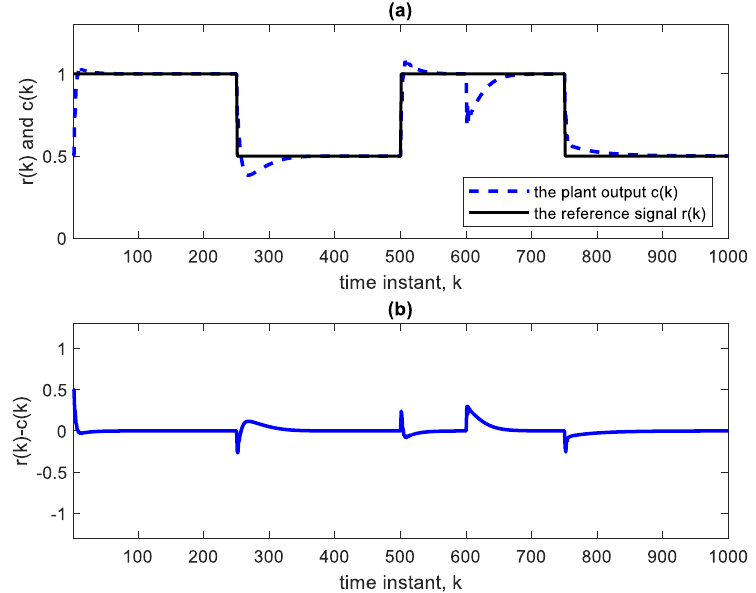
Figure 10. ( a ) Reference and plant output with a parameter change at the 600th sample, using adaptive filter as the inverse model of the nonlinear plant. ( b ) Error curve